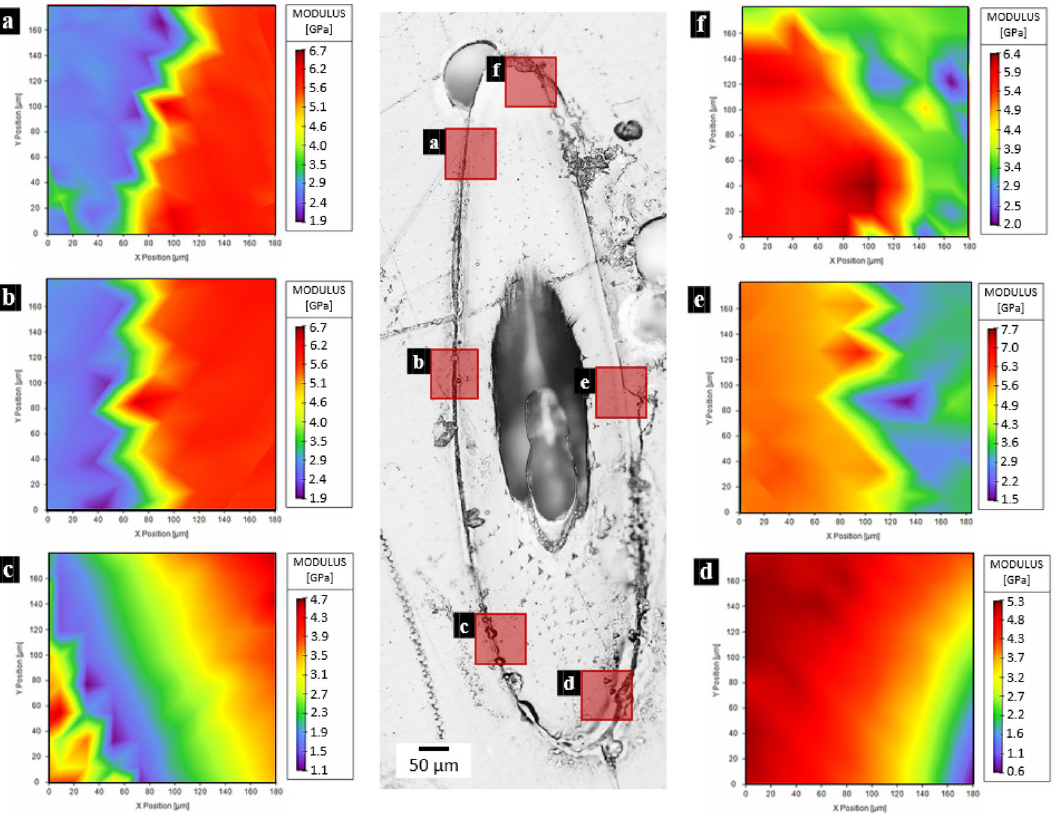
Figure 3. Map of Young’s modulus of the spider fang in the transversal section on the tip. In general, the outer layer of the sclerotized cuticle is stiffer than the internal. Images generated with the support of Nanoblitz 3d, Nanomechanics